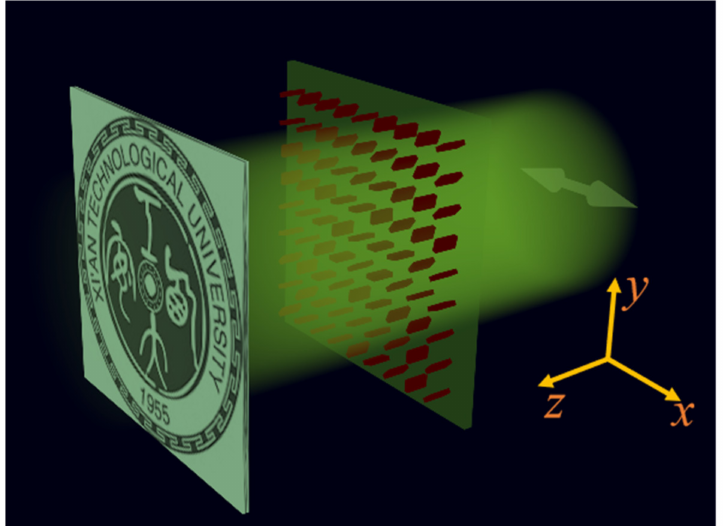
Figure 5. The schematic illustration of the continuous grayscale image display based on the nano‑ polarizer